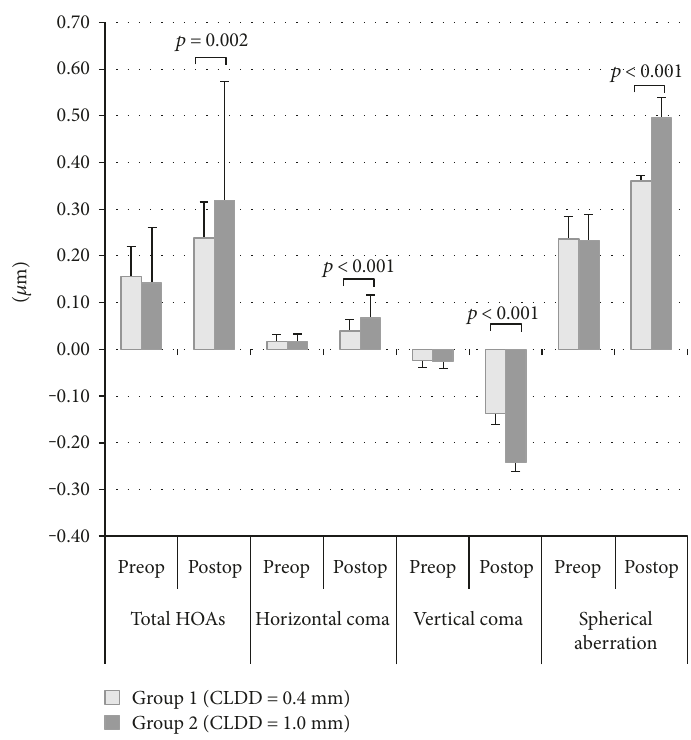
Figure 2: The mean higher-order aberrations ( μ m) of group 1 and group 2 before (preop) and six months (postop) after SMILE procedure. Although study groups had similar aberrations preoperatively, group 1 was associated with signi fi cantly higher induction of total HOAs, horizontal coma, vertical coma, and spherical aberrations than group 2 after SMILE procedure. HOAs: higher-order